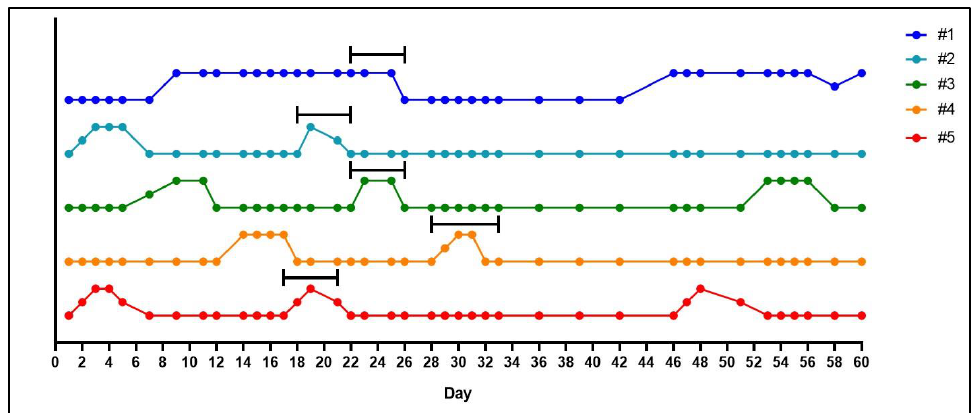
Figure 2. Graphical representation of the estrus cycle in the guinea pig based on monitoring of the vaginal membrane. In five animals, the vaginal membranes were monitored daily and observed as either ‘closed’, ‘open’, ‘opening’ or ‘closing’. A closed vaginal membrane was designated as the baseline and perforation of the membrane was marked as an increase away from the baseline. Females were placed with a male 14 days after perforation of the vaginal membrane was first observed, as indicated by the back bars above the colored lines. Monitoring throughout pregnancy also occurred, in which the vaginal membrane was observed as perforated in two (#3 and #5) out of the five animals. For female #1, observations of a perforated vaginal membrane on day 46 also included blood in the vaginal lumen and a decrease in maternal weight gain. A later ultrasound confirmed the loss of pregnancy in this animal.